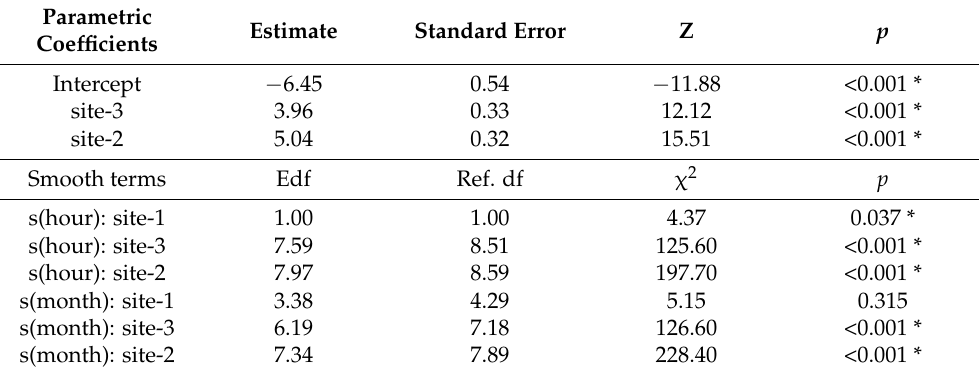
Table 5. The table below summarizes a negative binomial GAM model used to examine the effect of recording time and month on E. scolopaceus ’s activity. The recording hour and month were modeled independently with smoothed function for each monitored site, while the cyclic predictor was modeled using a cyclic cubic regression spline. Reference degrees of freedom was used to calculate test statistics and p -values are represented by Ref. df, whereas Edf (Effective degrees of freedom) indicates the curviness of the